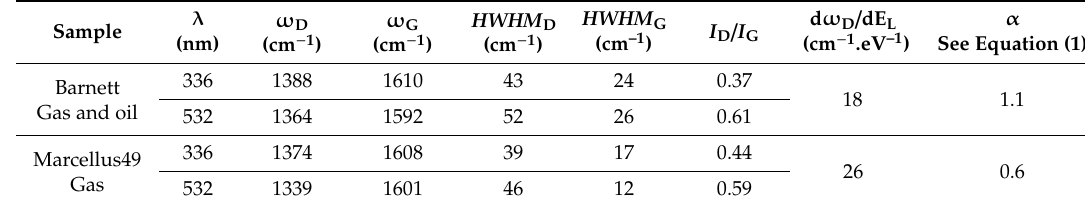
Figure 3. Raman spectra of the Marcellus49 gas-shale obtained with an excitation wavelength of ( a ) 336 nm and ( b ) 532 nm. The fitting (red line) and its components (blue lines) are also shown. ( c ) and ( d ) show comparisons of both spectra (blue: 336 nm spectrum; green: 532 nm spectrum) while normalizing them using the G band intensity ( c ) and the D band intensity ( d ). The vertical lines represent the position of the D band for graphite for each excitation energy. Table 1. Fitting parameters corresponding to Figure 1 and Figure 2.